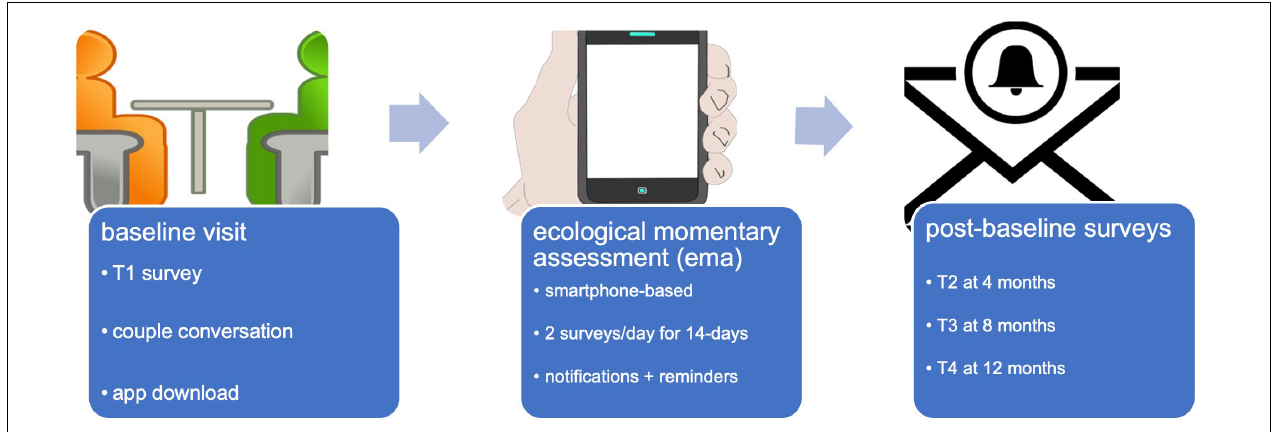
FIGURE 1 | Study activities. Icons made by Freepik from